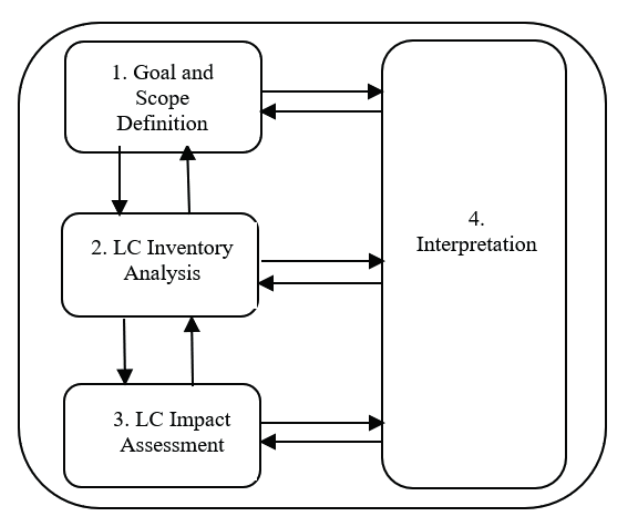
Fig. 2. Schematic structure of life cycle assessment